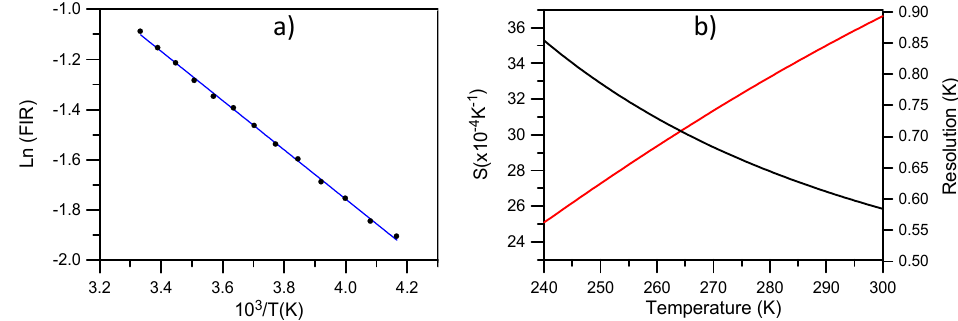
Figure 8. Upconverted green emission as a function of temperature in the 300 K–240 K temperature range obtained under excitation at 806 nm.